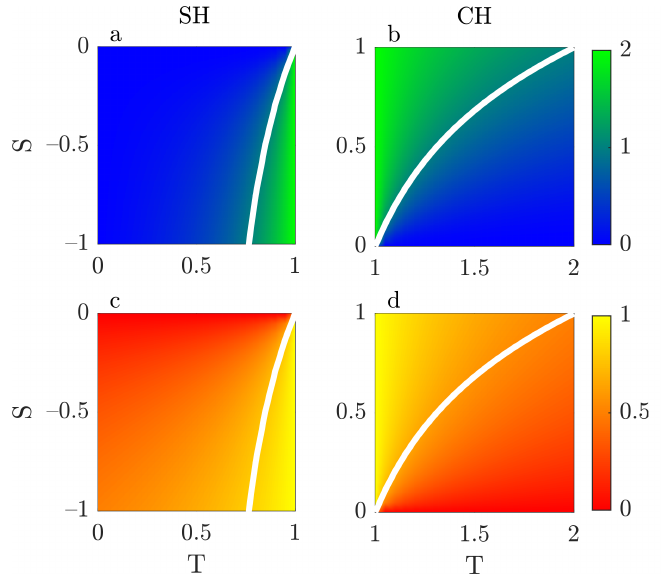
Figure 5. Payoff φ ( x v , x w ) (Equation (3)) and mixed equilibrium x ∗ (Equation (11)). SH game AM (subplots a , c ): T ∈ [ 0,1 ] and S ∈ [ − 1,0 ] . CH game (subplots b , d ): T ∈ [ 1,2 ] and S ∈ [ 0,1 ] . The white lines indicate the locus of values S and T for which the players choose full cooperation (subplots a , b ) and the corresponding values of x ∗ (subplots c , d AM